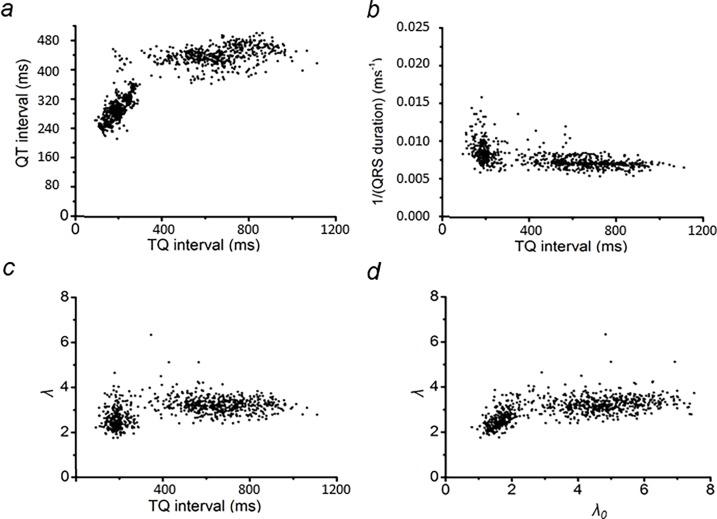
Representative figure for the analysis of QT interval and wavelength restitution plots.Plots of QT interval (a) and 1/(QRS duration) (b), and λ0 (c) against TQ interval, and λ against λ0 (d).